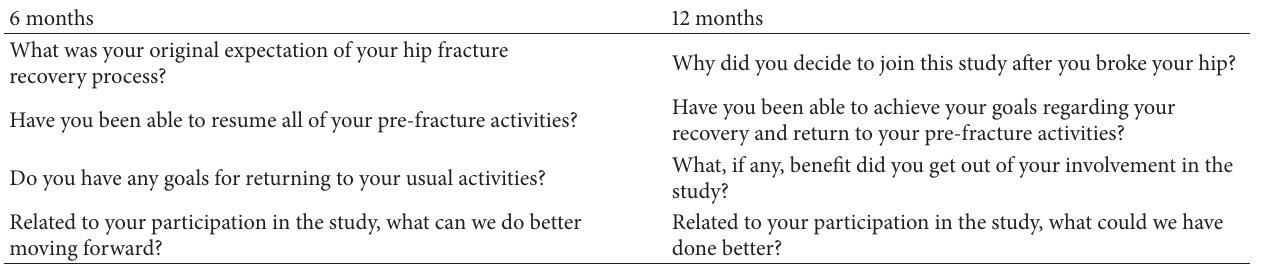
Table 2: Interview guide questions at 6 and 12 months after study